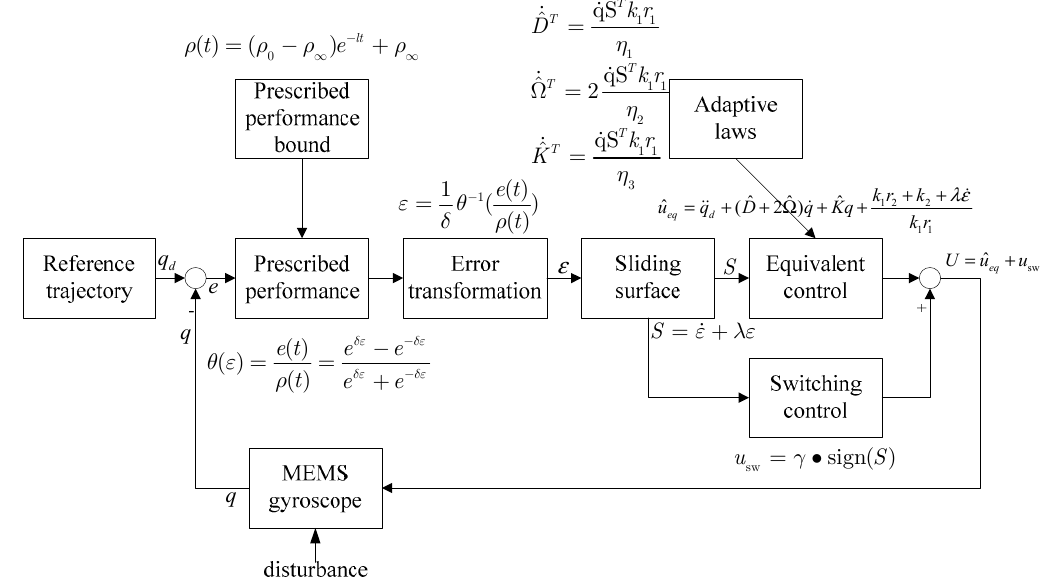
Figure 3. Structure of the adaptive prescribed performance sliding mode control (APPSMC) system.